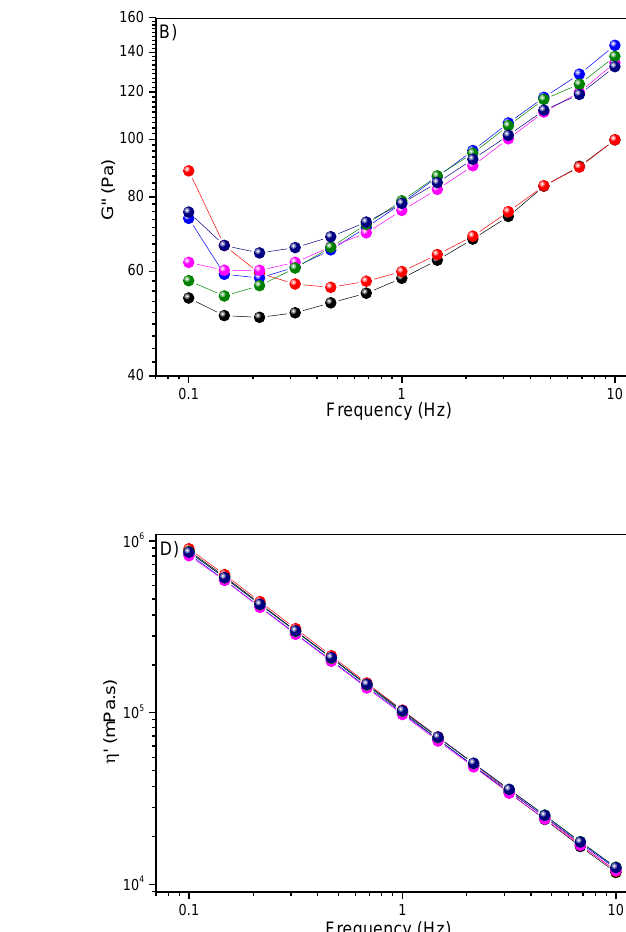
Figure 4. Viscoelastic properties of emulsion-filled gels in terms of oscillatory frequency: ( A ) elastic moduli (G’); ( B ) viscous moduli (G”); ( C ) loss tangent (Tan δ ); ( D ) dynamic viscosity ( η ’). The symbols refer to FC at 25.0 °C, FC at 37.0 °C, ECO 15 at 25.0 °C, ECO 15 at 37.0 °C, ECO 20 at 25.0 °C, ECO 20 at 37.0 °C. The insert ( C ) corresponds to the rheological dynamics required to obtain the lag angle.